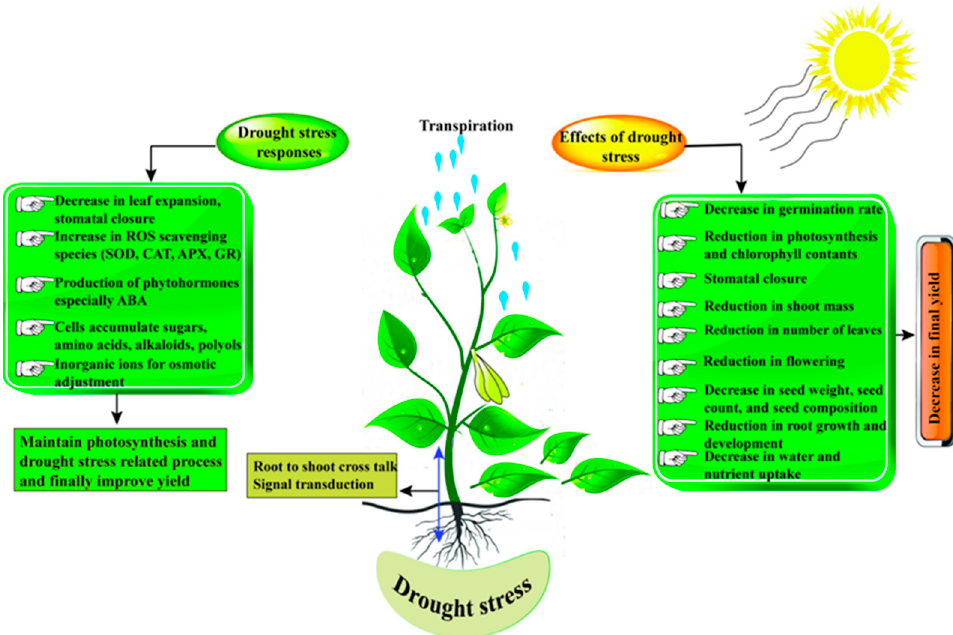
Figure 1. Effect of drought stress (DS) on plants and possible responses. 114 Figure 1. E ff ect of drought stress (DS) on plants and possible